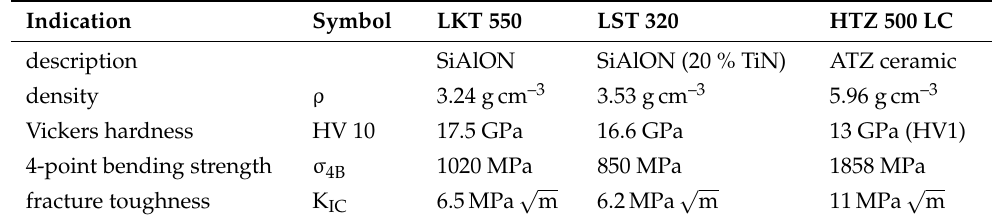
Table 1. Physical properties of the treated